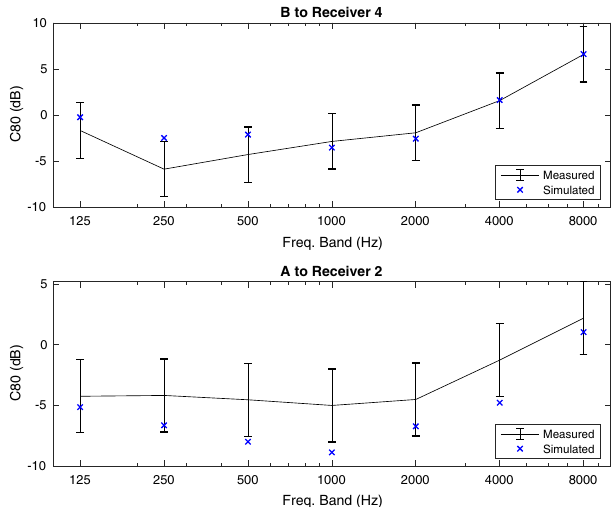
Figure 7. C80 simulations versus measurements for positions B4 and A2 (Error bars = ±2 JND).